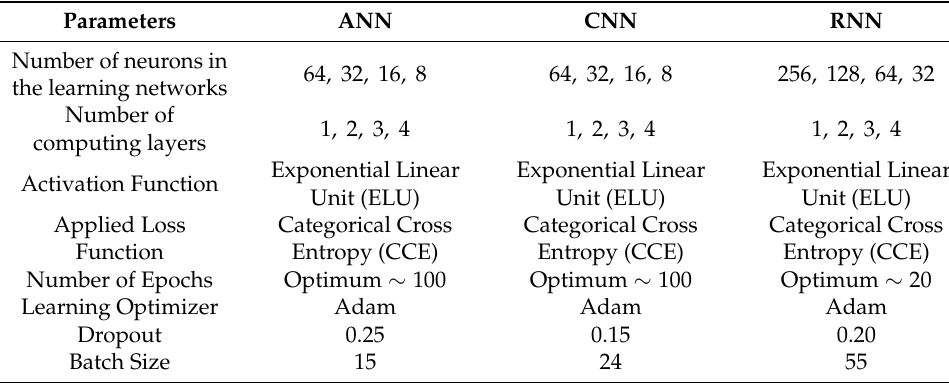
Table 2. Significant parameters of the classifier